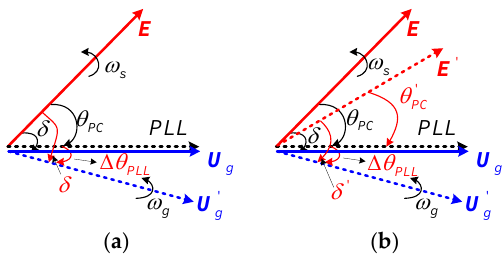
Figure 7. Phasor diagram with reducing the control bandwidth of PLL . ( a ) Type ‐ 3 WTs; ( b ) Type ‐ 4